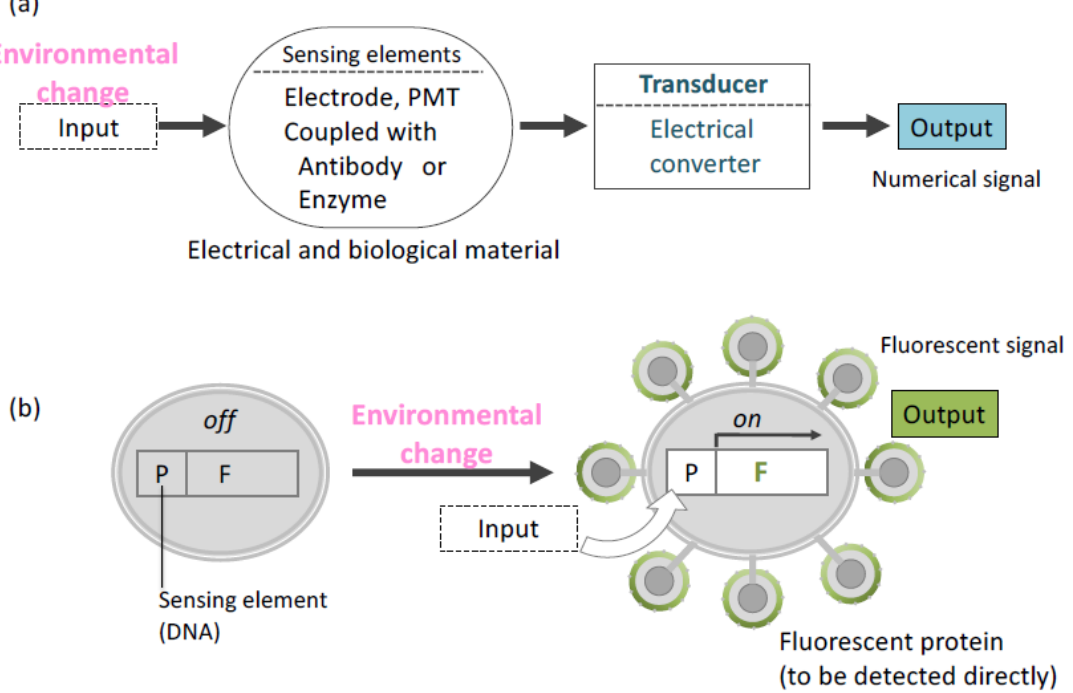
Figure 4. Overview of concepts about biosensing. ( a ) Conventional system ( b ) Cell sensor. In a cell sensor, “Environmental change” as input signal is converted to output signal at the identical place (cell). P: promoter, F: Gene encoding fluorescent